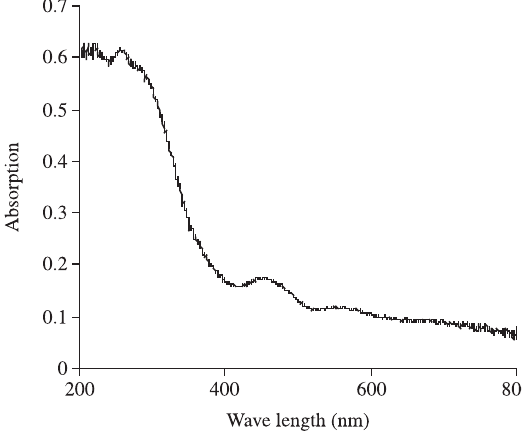
Figure 5. Fourier transform infrared spectrum of mesoporous Mn – organo- phosphate molecular sieve.